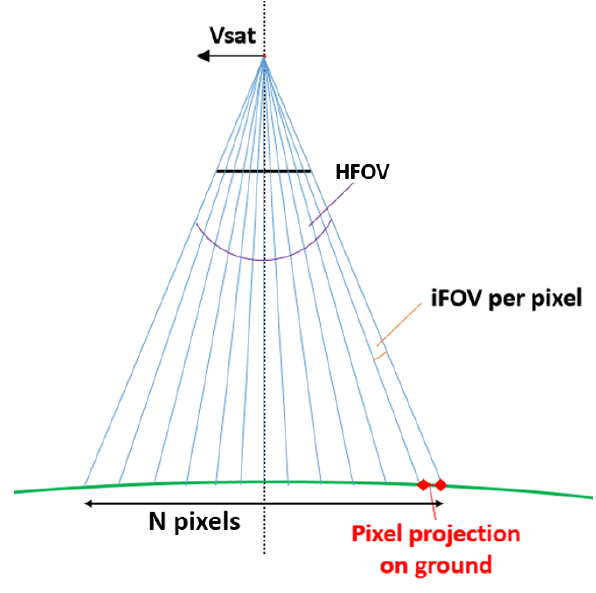
Figure 2. 2D representation of HORUS iFOV. 3. HORUS Multiangle and Multispectral Observation Module To cover a sufficiently large off-nadir angle with appropriate optical characteristics, multiple cameras can be used, with appropriate boresight angle (off-nadir-tilt in the along- track direction). In the implementation selected for HORUS, the complete angle coverage is obtained with four sets of four identical cameras, or camera quadruplet, as shown in Figure 3. The Type (a, b, c, d) within the camera quadruplet respectively indicates the position in the sequence in the off-nadir order, starting from forward off-nadir and ending with afterward off-nadir camera pointing. Each camera HFOV is aligned in the along-track direction, covering a FOV of 33.4 degrees. All the cameras are mounted on the spacecraft with boresight angles of ± 16.7 ◦ and ± 50.1 ◦ . This arrangement allows continuous coverage of a full range of nadir angles from 66.8 degrees forward to 66.8 degrees afterward.